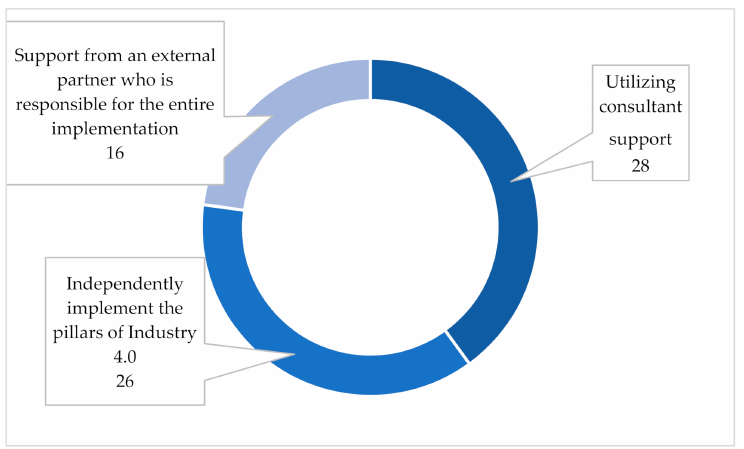
Figure 6. Ways of implementing Industry 4.0